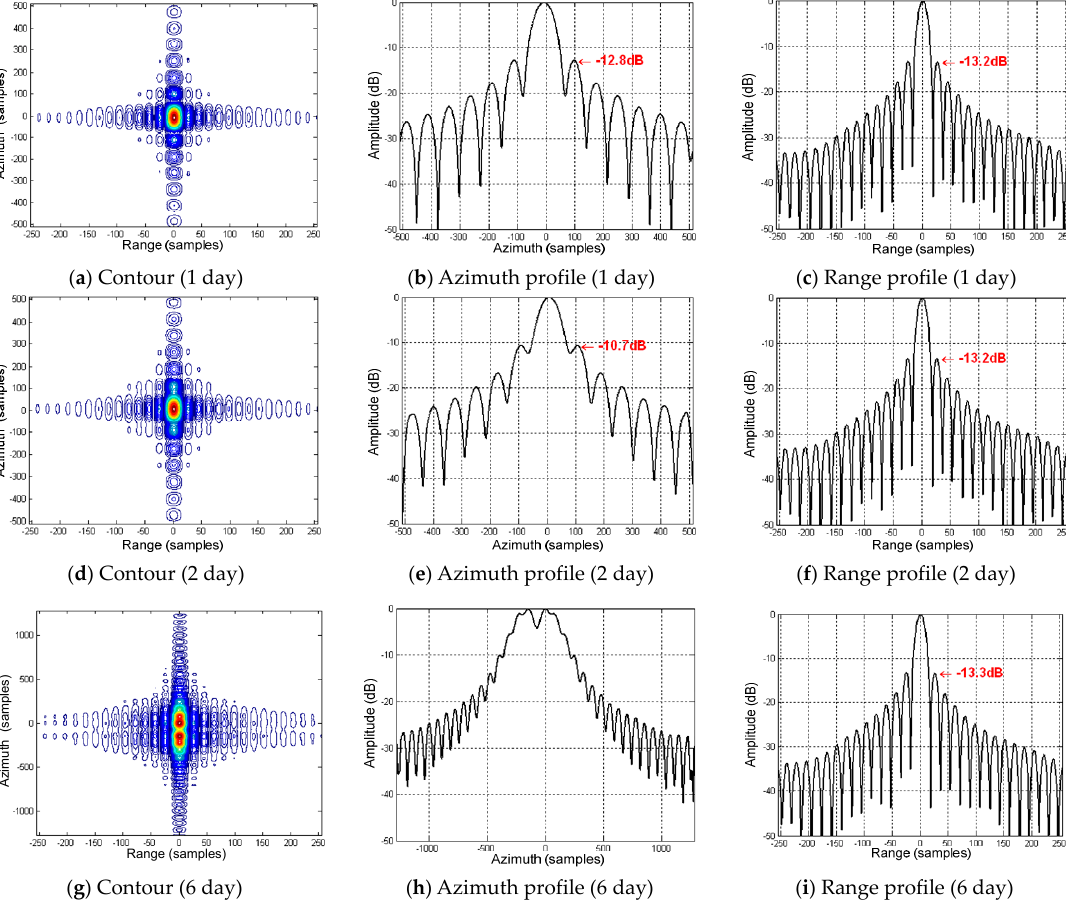
Figure 8. Variations of the slant range history and the Doppler coefficient (Doppler centroid: f dc , frequency modulation rate: f dr and third-order Doppler rate: f drr ) of the perturbed GEO SAR within one aperture at perigee.